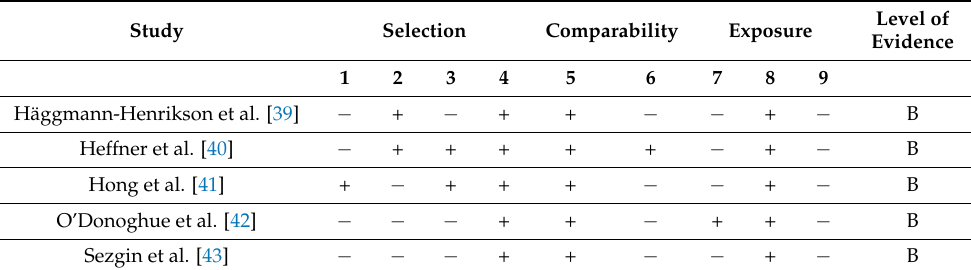
Table 3. Methodological quality of case-control Studies.